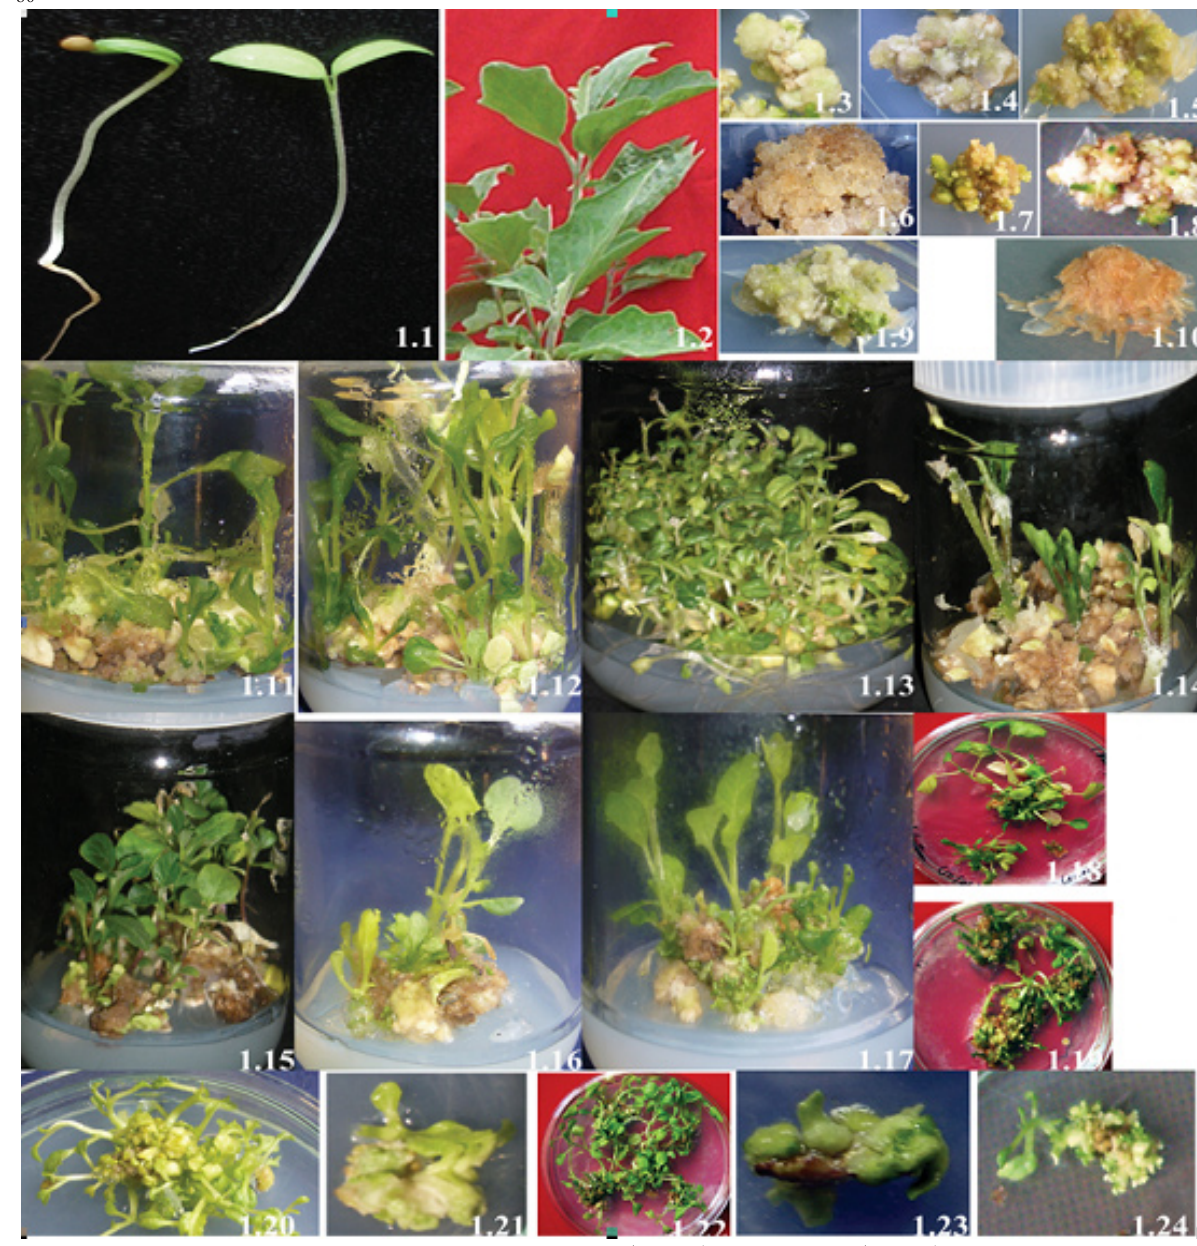
Fig. 1. In vitro response of type-I explants of Solanum genotypes : (1.1-1.2) explant types; (1.3-1.9) Callus segments of different genotypes showing variation in the morphology and quantities of embryogenic and non embryogenic portions; (1.10) Rooty cal- lus; (1.11-1.17) Differential response of seven genotypes on multiple shoots in MSKB medium; (1.18-1.24) Response of seven genotypes on direct regeneration in BAP supplemented medium. All the calluses and multiple shoots shown were nearly at the same development stage and in the same culture